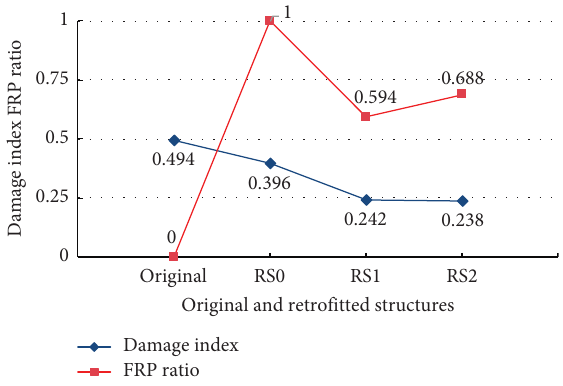
Figure 21: Variations of damage index and FRP